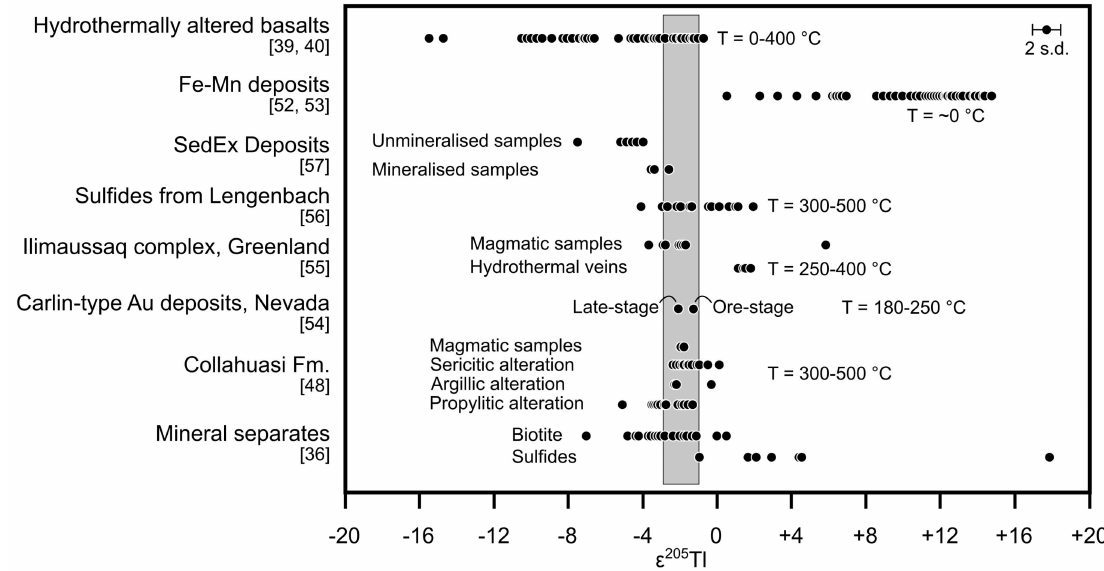
Figure 2. Summary of published Tl isotope ratios in hydrothermally altered basalts [39,40], Fe-Mn deposits [52,53], hydrothermal ore deposits [48,54–57], and mineral separates of biotite and sulfide from various geological environments [36]. The grey box represents the nominal mantle value of ε 205 Tl ( − 2 ± 1 [31,41]); long-term external 2 s.d. reproducibility of several reference materials of ± 0.5 [31,42] shown as error bars for